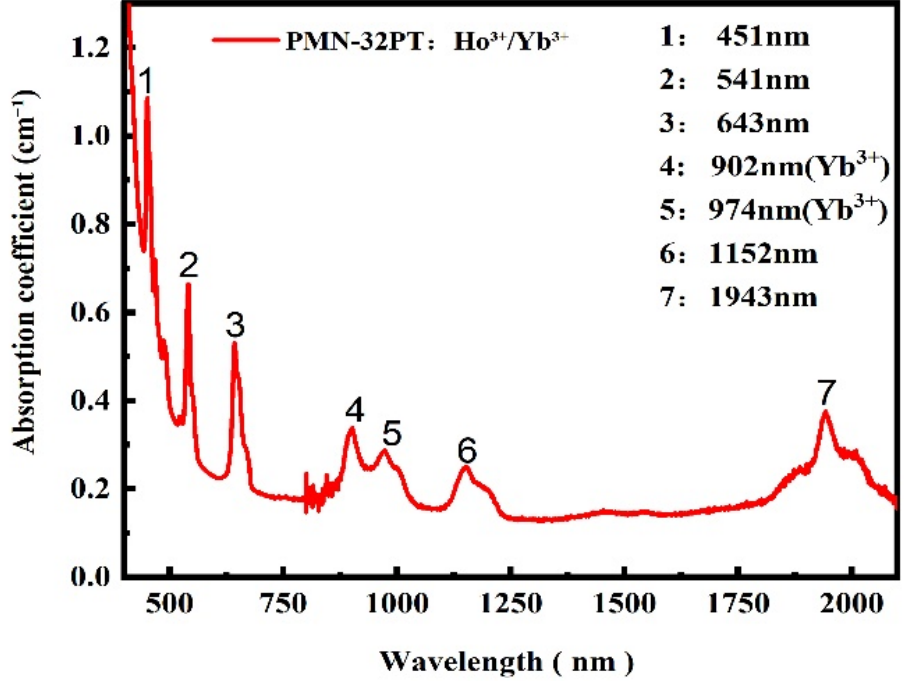
Figure 5. The absorption spectra of PMN-32PT:Ho 3+ /Yb 3+ crystals.